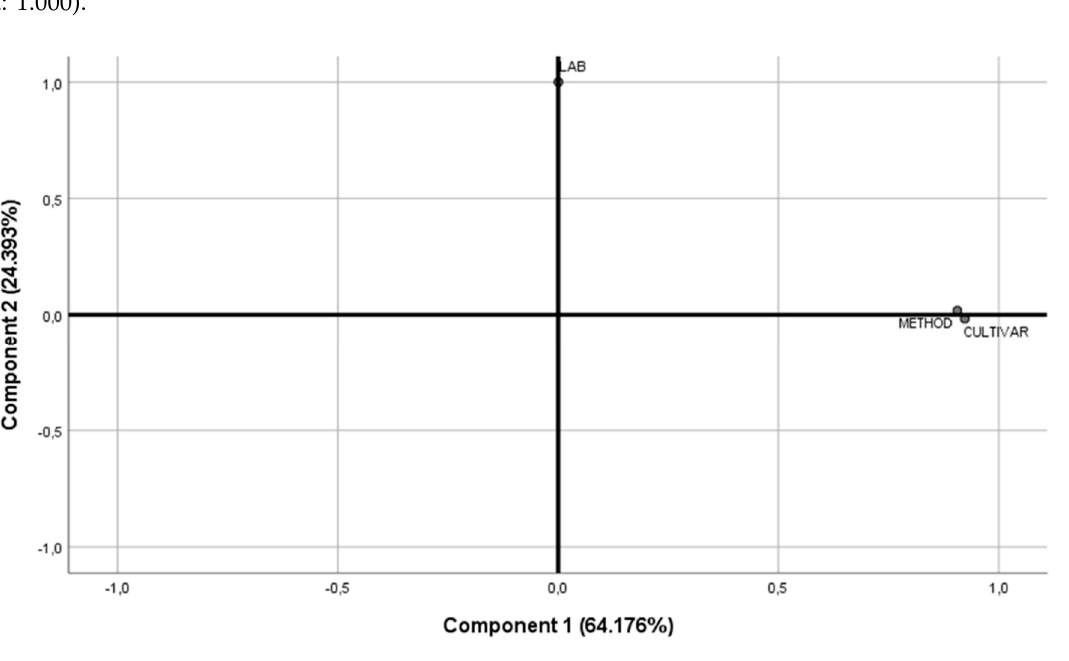
Figure 7. Plot of communalities from component extraction method, considering the variables LAB, cultivar, and method type.